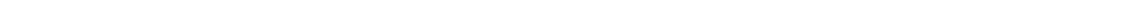
Fig. 3 GSK3 activity is required for neural crest cell migration. a , b Neural crest cells from st 17 Xenopus embryos ( n = 9). a Control explants after 8 h in culture. b Upon GSK3 inhibition, neural crest cells spread signi fi cantly less than the controls. c Quanti fi cation of the distance migrated * p < 0.05. ( d , g , j ) Control mouse explants. e , h Explants treated with 0.5 µ m BIO or 1 µ M CHIR99021, respectively. Note the decrease in area covered by migratory neural crest ( f , refers to d , e ; i refers to g , h ). Each dot represents one explant (** p < 0.001, unpaired t -test) j – l Mouse explants from control ( j ), Wnt1::cre; GSK3a fl / + ; GSK3b fl / + ( k ) and Wnt1::cre; GSK3a fl / fl ; GSK3b fl / fl complete mutants ( l ). Note the decrease in area covered in l (red dotted line). m –